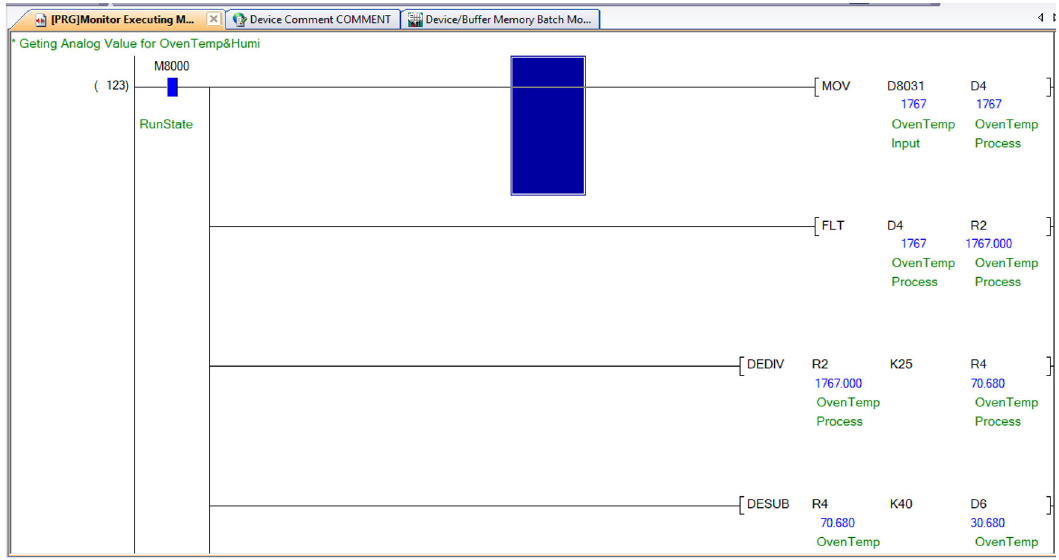
Figure 10. Temperature reading in ladder logic program.